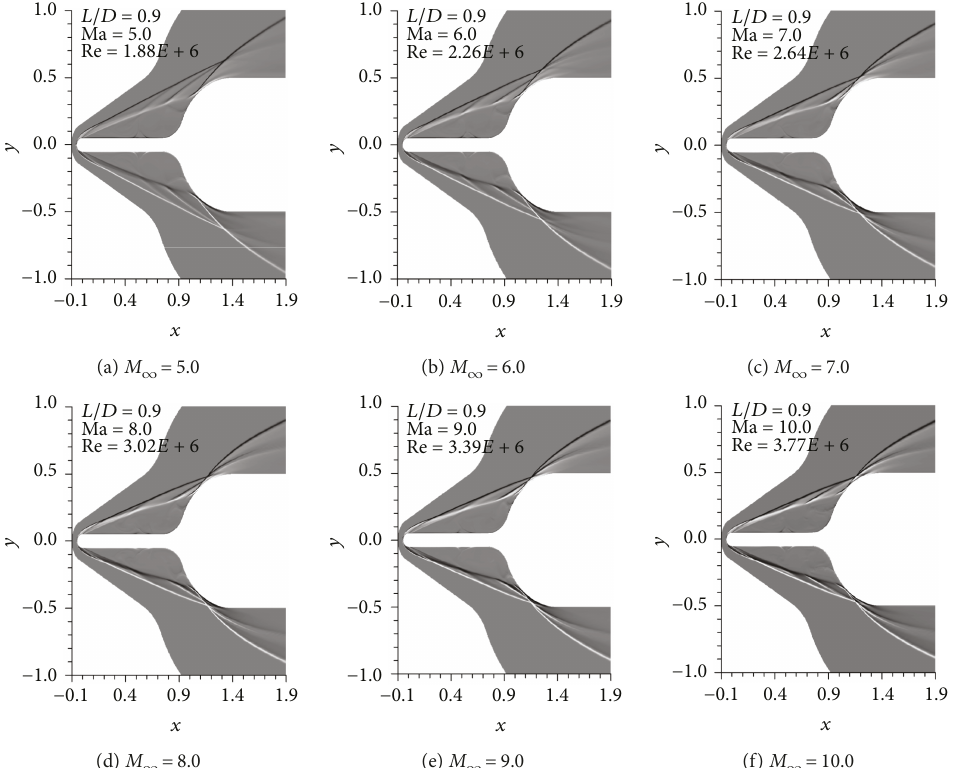
Figure 7: Flow fi eld density gradient in y direction of pure spiked blunt bodies. Spike length L/D = 0.9. L/D = 1.0 Ma = 5.0